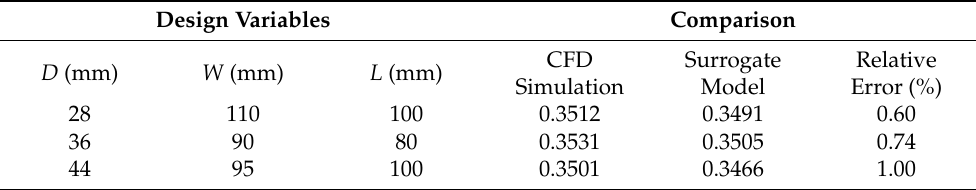
Table 6. Comparison of C d between CFD simulation results and surrogate model results.